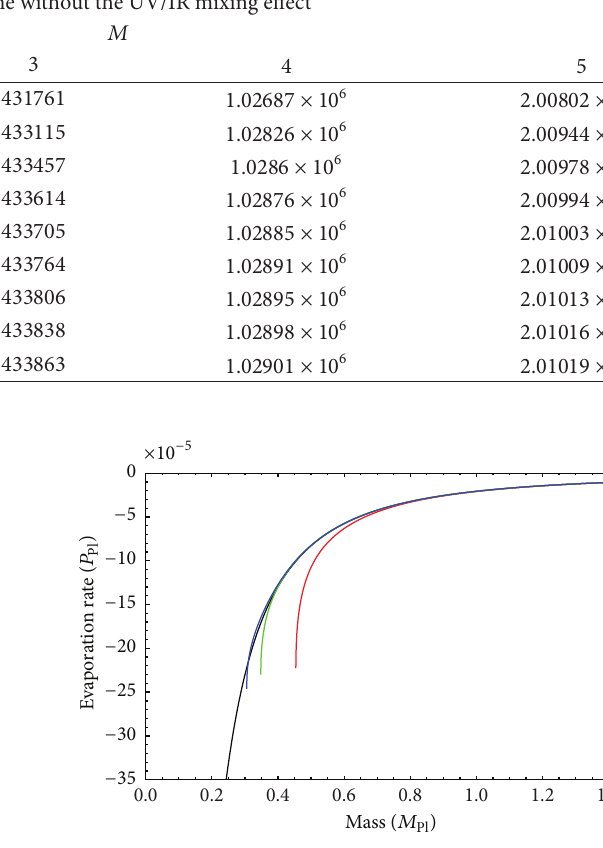
Figure 7: The evaporation rate versus the black hole mass for the case 𝑛 = 2 . From left to right: the Hawking result (black solid curve), GUP 2 result (solid curve), GUP 0 result (dashed curve), and GUP 1 result (dotted curve) for 𝛼 = 0.75 (red), 𝛼 = 1 (green), and 𝛼 = 1.25 (blue), respectively.